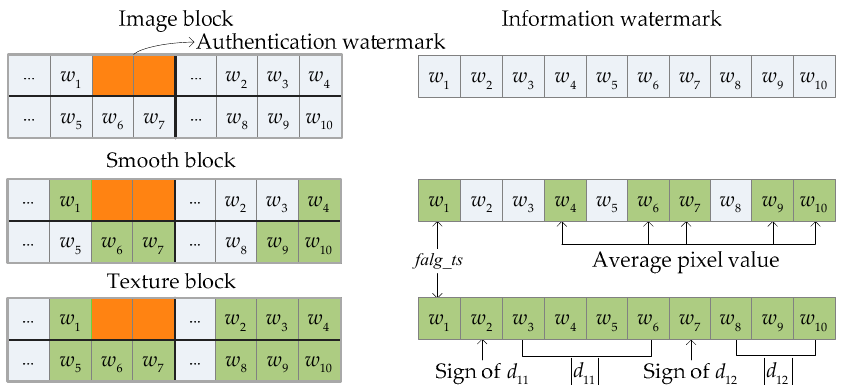
Figure 5. Embedding bits and the corresponding image watermark information.